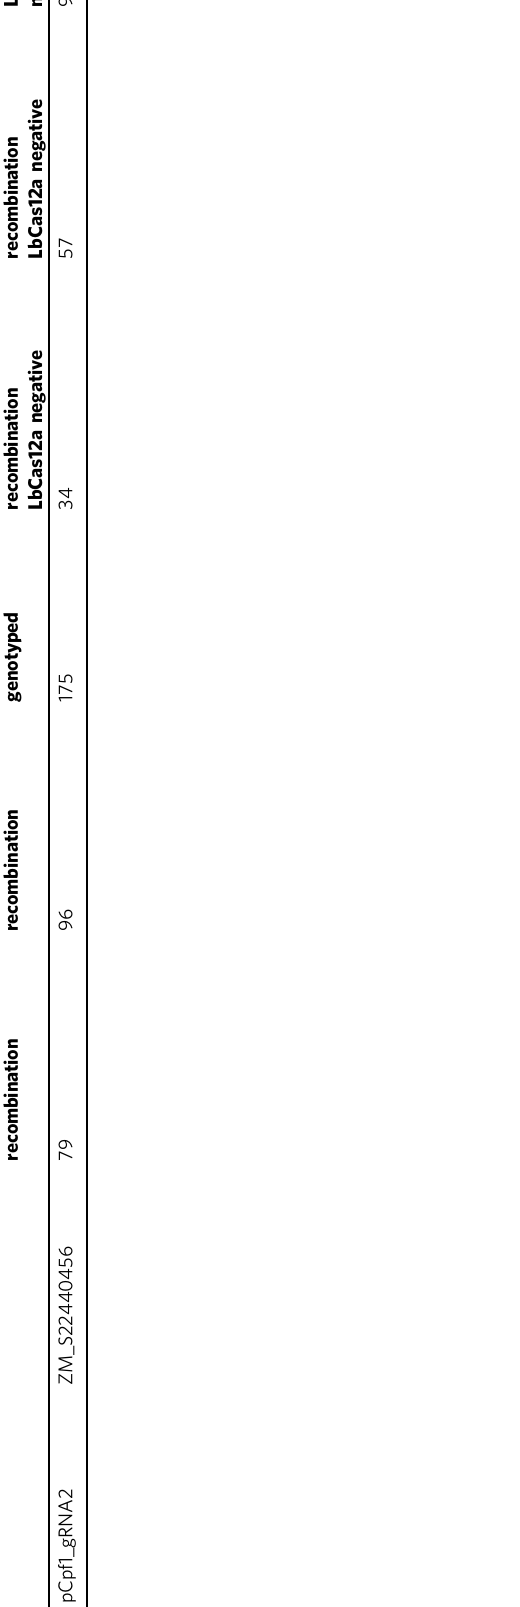
(Fig. 4b: labeled Light Green and Blue, Supplementary Data 1) at the expected segregation ratio of 1 homozygous CO:2 hetero- zygous CO:1 homozygous wild-type (no CO) in all three